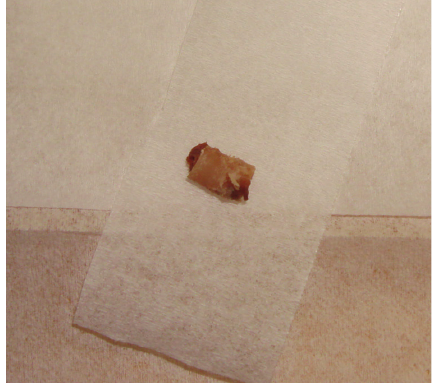
Figure 3: Excised bone cylinders using the surgical stent.